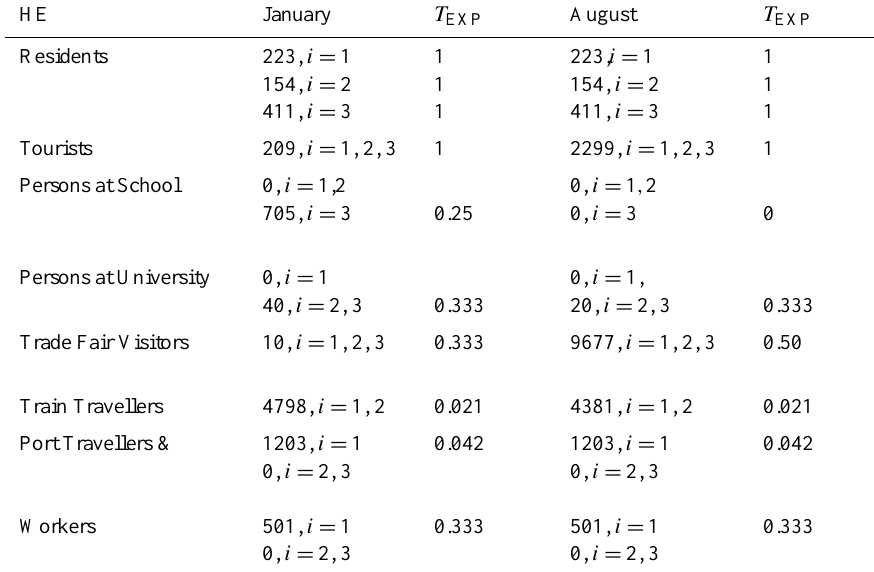
Table 2. Daily HE in the TRZ i (i = 1 , 2 , 3) in January and in August and corresponding assumed T EXP . HE January